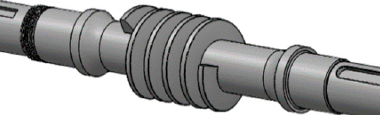
Figure 7. Transmission shaft with endless.